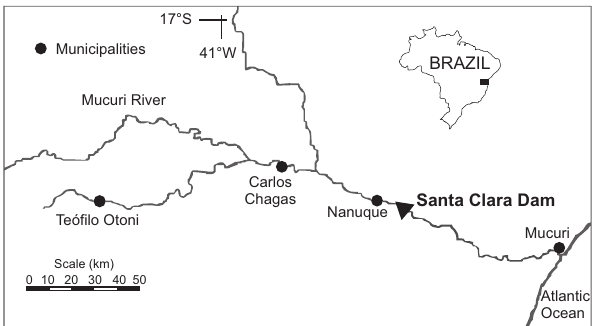
Figure 1. Mucuri basin, indicating the location of Santa Clara